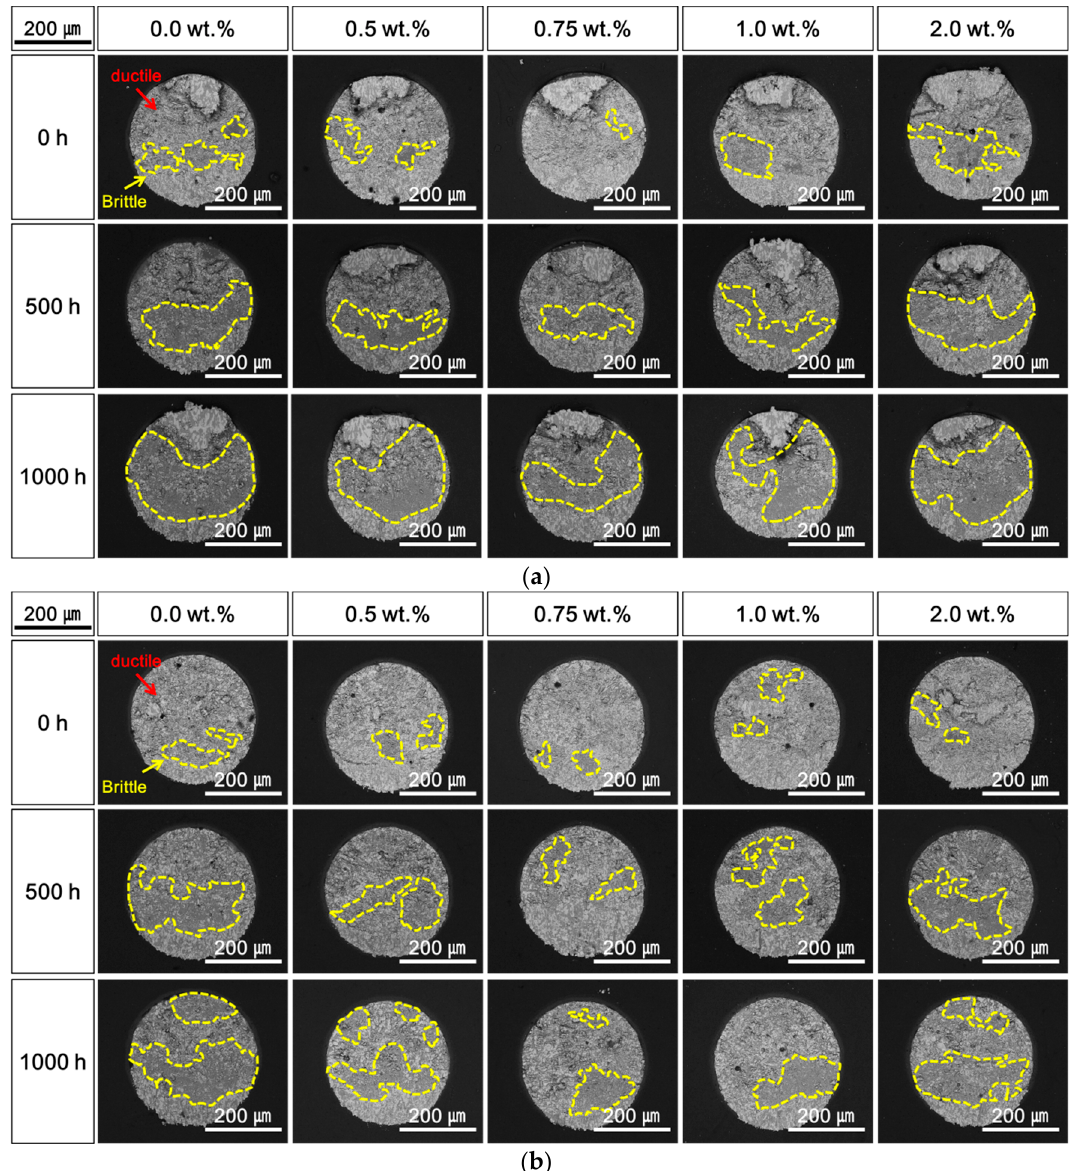
Figure 8. Top-view scanning electron microscopy (SEM) micrographs of fracture surfaces after a high-temperature storage (HTS) test at 85 °C: ( a ) 0.1 m/s and ( b ) 1.0 m/s.